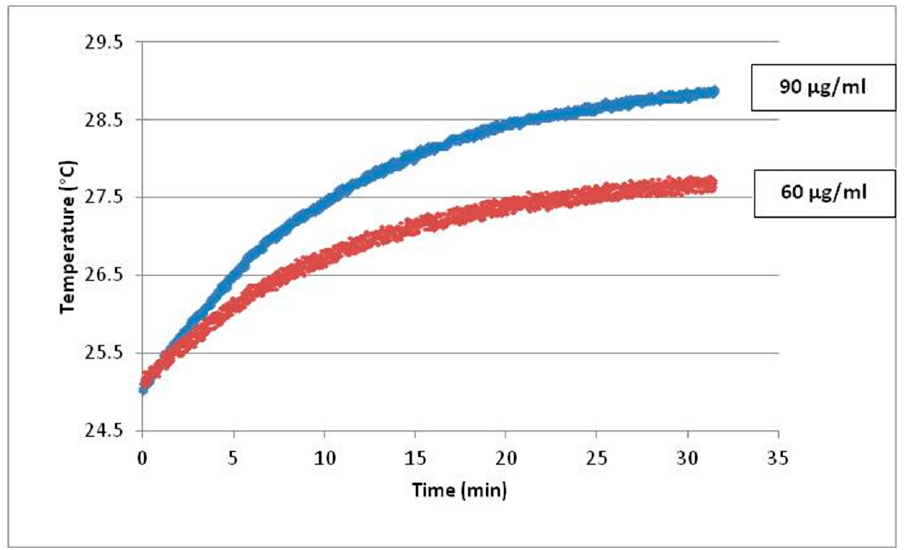
Figure 1. Kinetics of temperature increase versus exposure time for block polymer coated Fe 3 O 4 -NPs 90 μ g/mL (blue curve) and 60 μ g/mL (red curve).